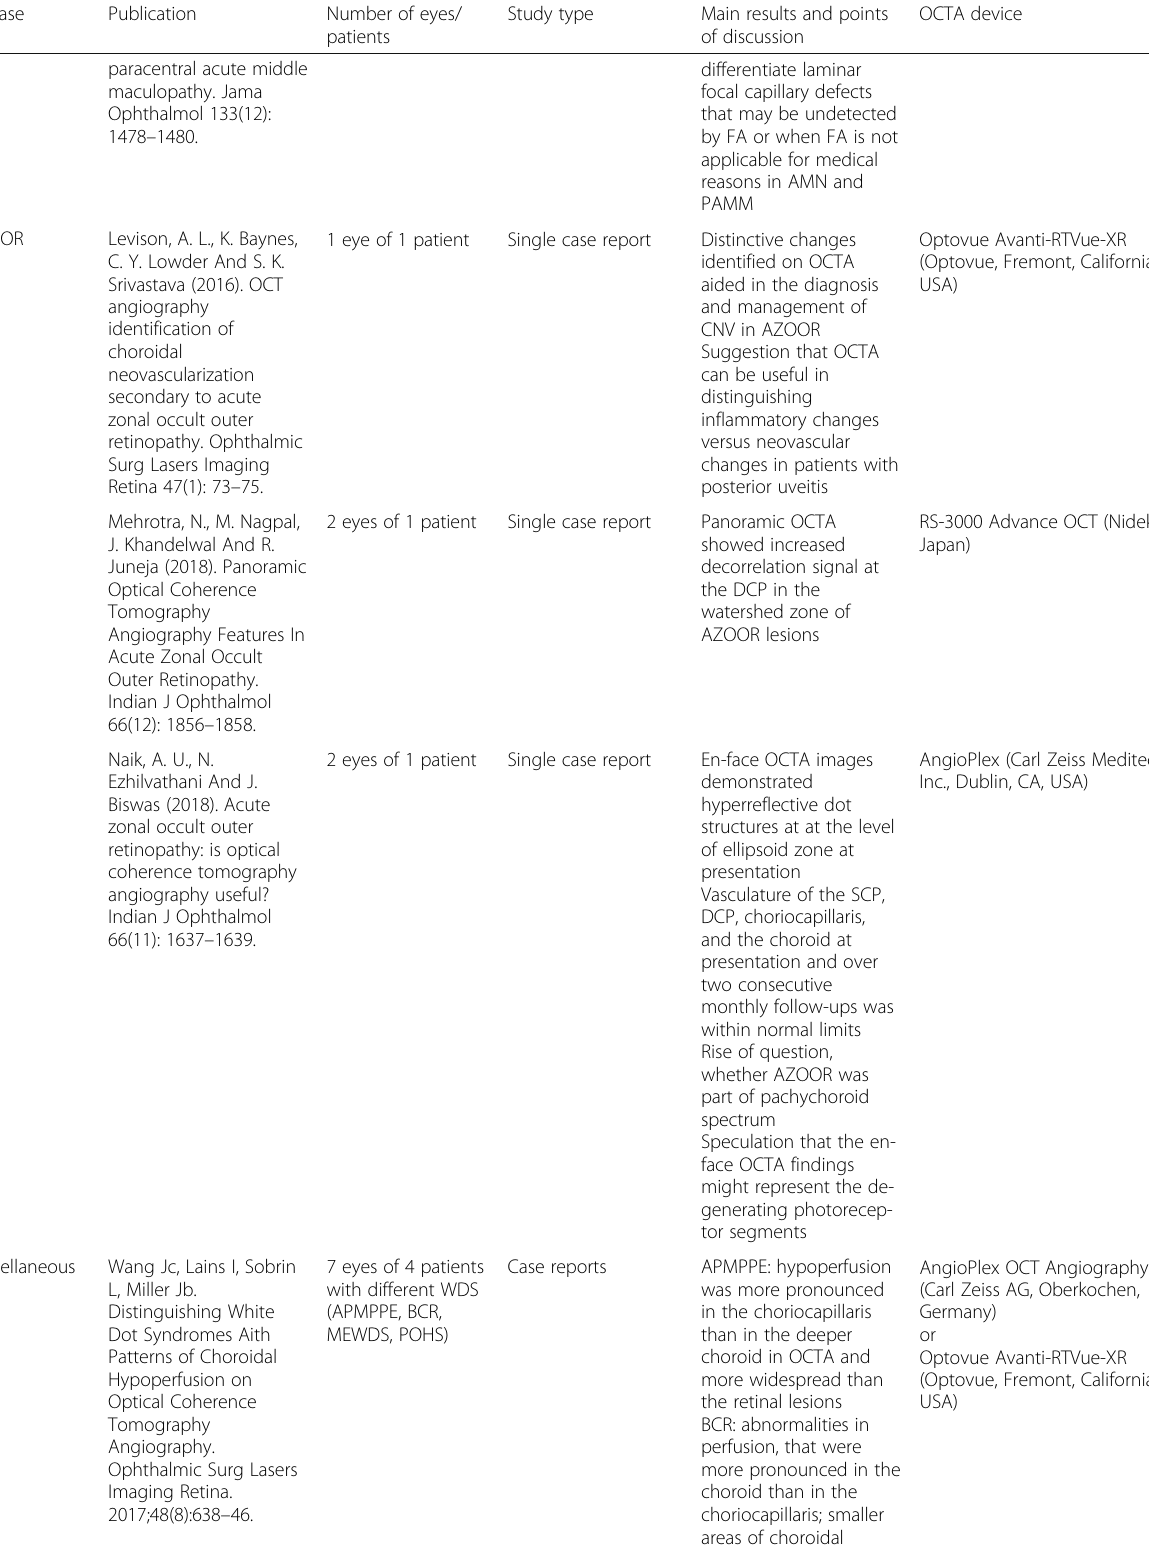
Table 1 Summary of publications on the implementation of OCTA in white dot syndromes (Continued)